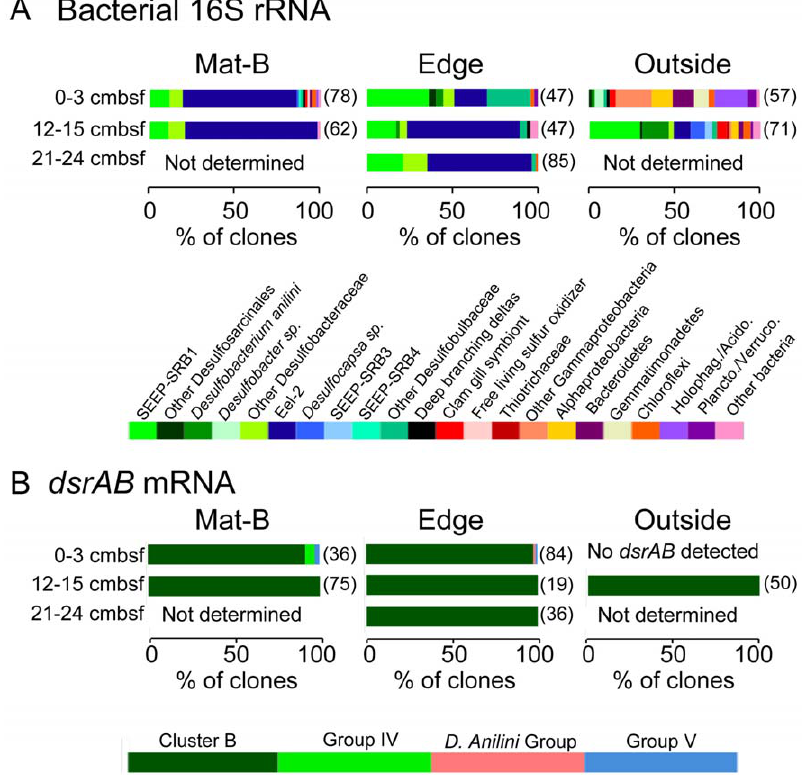
Figure 3. Bacterial community structure and stratification. Phylogenetic affiliations of (A) bacterial 16S rRNA transcripts, and (B) dsrAB mRNA transcripts at different depths across the mat transect. Shown are the percent of clones obtained from each group in the color coded bar graph legends. In A), shades of green and blue denote putative sulfate-reducing groups. Numbers in parentheses are the total number of clones analyzed, including full length and short reads. ‘‘Not determined’’ means that no amplification was